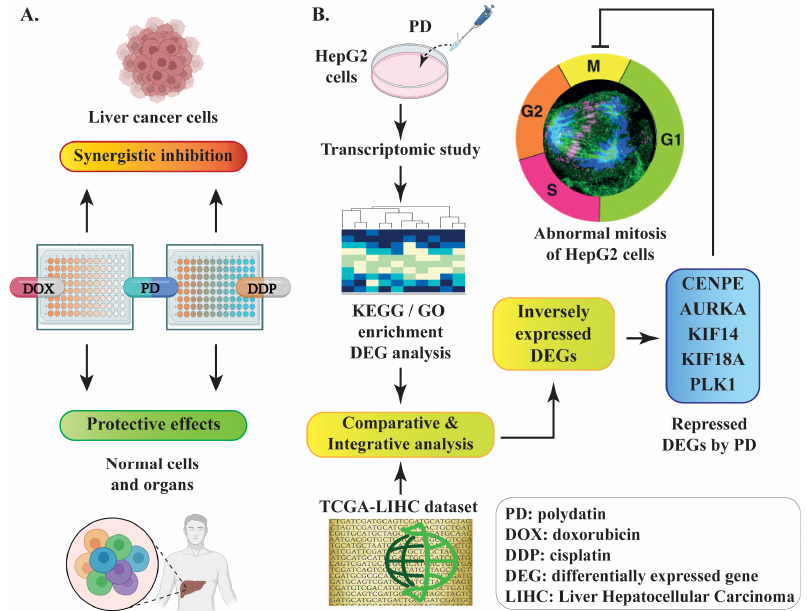
Figure 8. Schematic diagram of the experimental design and discovery in the current study. ( A ) PD ‐ mediated synergistic inhibition to liver cancer cells and protective effects on normal cells when combinatorially used with DOX or DDP. ( B ) The discovery of PD ‐ repressed DEGs related to mitosis through comparative or integrative analyses of the RNA ‐ seq dataset from PD ‐ treated HepG2 cells and a TCGA ‐ LIHC dataset of liver cancer patients.